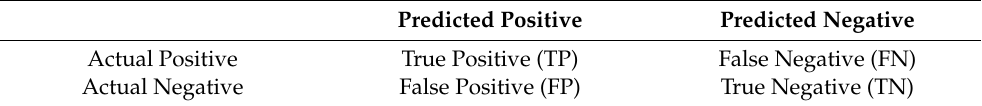
Table 1. Confusion